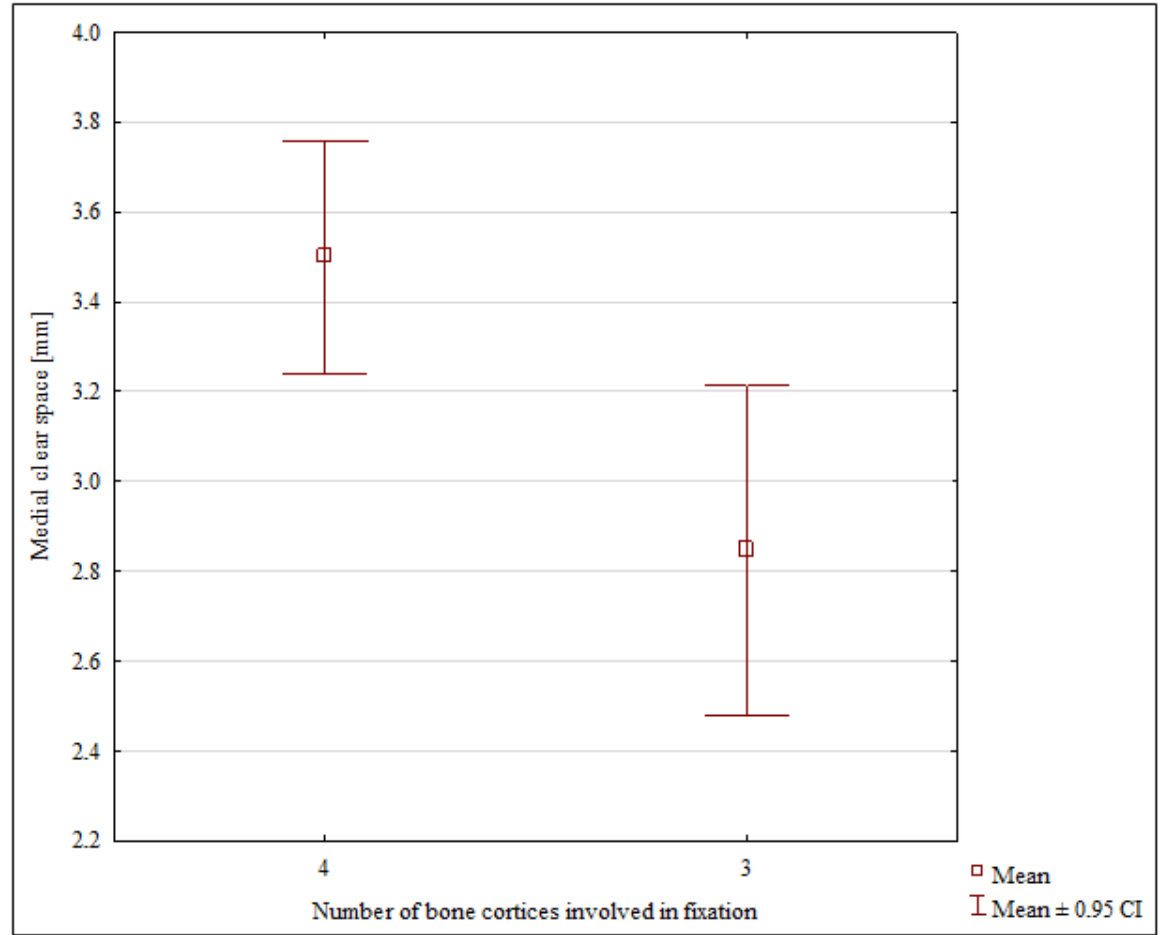
Figure 1. Medial clear space values in the tricortical and quadricortical fixation groups.